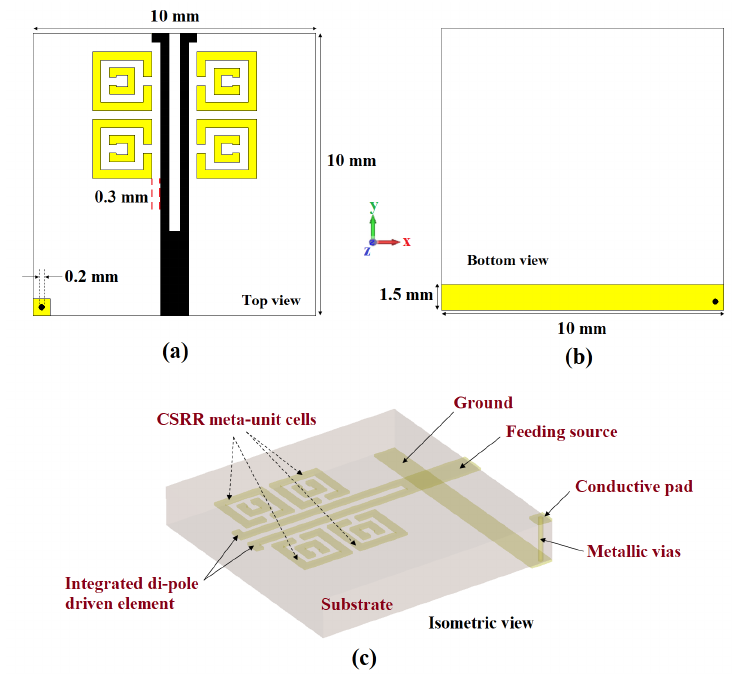
Figure 1. Proposed one-element antenna: ( a ) top view, ( b ) bottom view, and ( c ) isometric view.